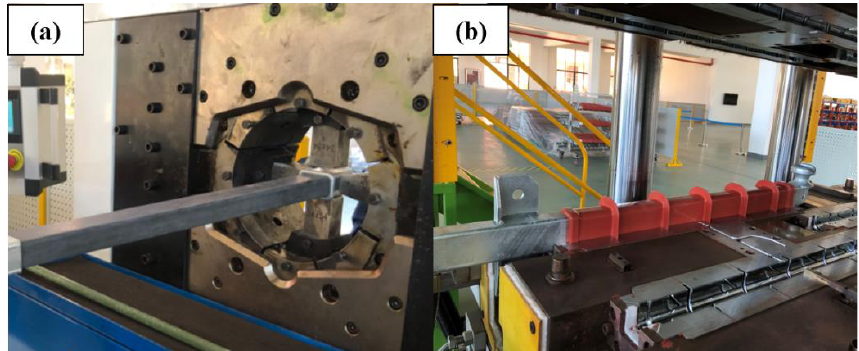
Figure 2. Fitting crimping ( a ) and silicone rubber shed injection ( b ).